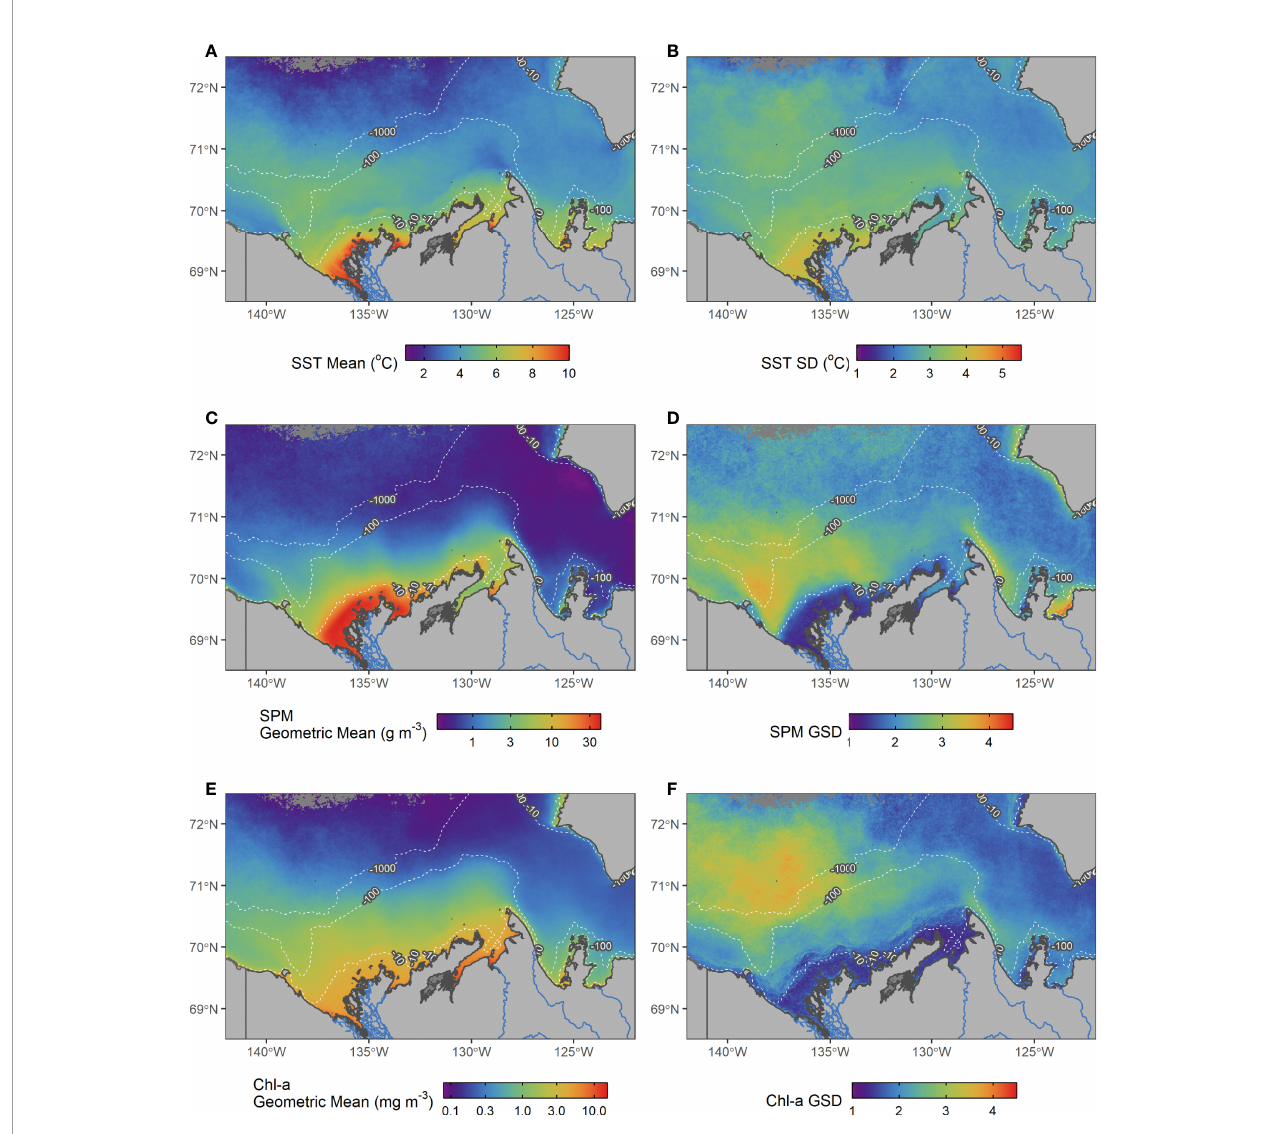
FIGURE 3 | Mean and SD maps of SST (A, B) , SPM (C, D) and Chl-a (E, F) for the time period 2003 – 2019 (note different colour scales). The GSD used for SPM and Chl-a is unitless. The 10, 100 and 1000 meter bathymetric contours are shown as dashed white lines. Dark grey ocean pixels indicate areas with inadequate